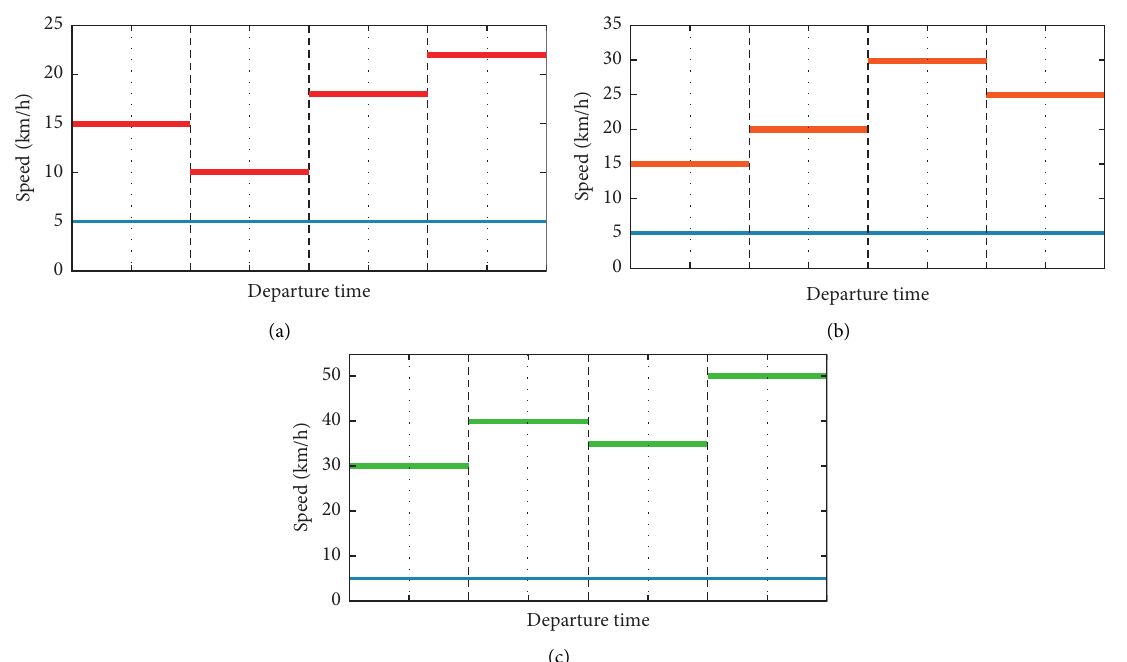
Figure 9: (a) Speed changes for the first scenario-high traffic; (b) speed changes for the second scenario-medium traffic; (c) speed changes for the third scenario-low